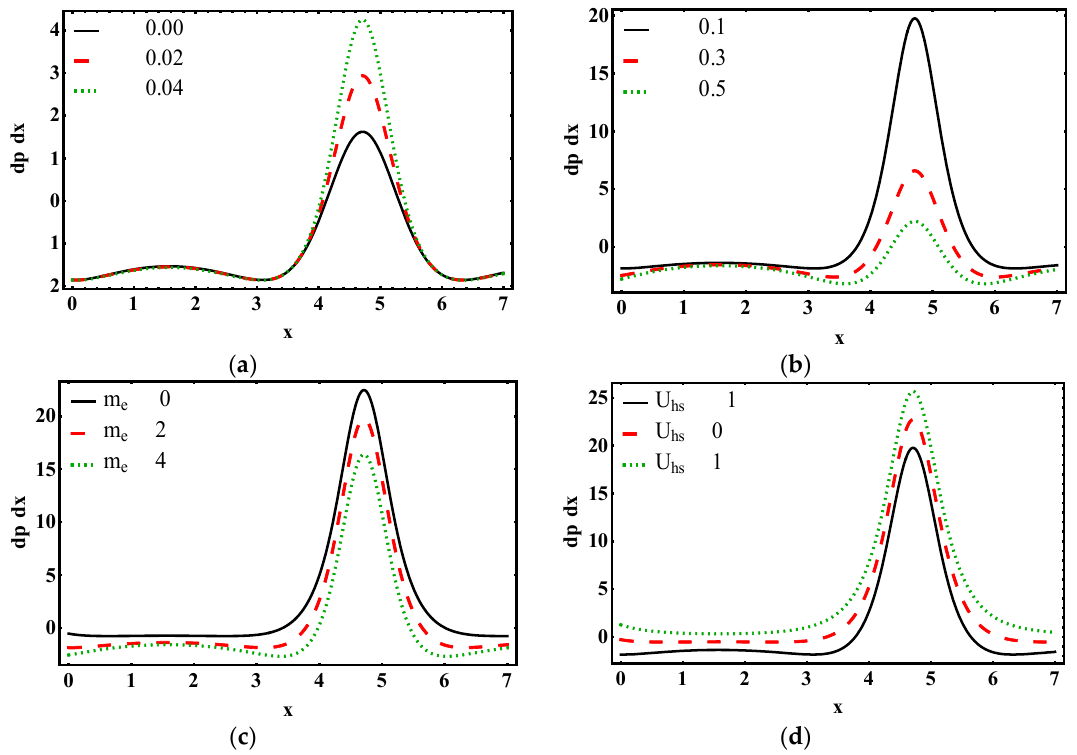
Figure 5. Pressure gradient profile for ( a ) . Г ( b ) . Θ ( c ) . m e ( d ) . U hs , while other parameters are Г = 0.01, ε = 0.4, Θ = 0.1, m e = 2, U